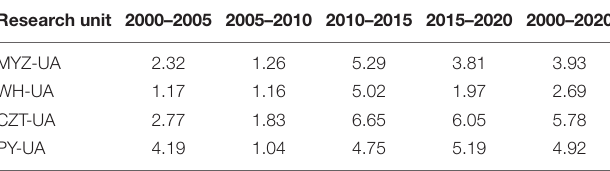
TABLE 1 | Intensity index of construction land expansion from 2000 to 2020